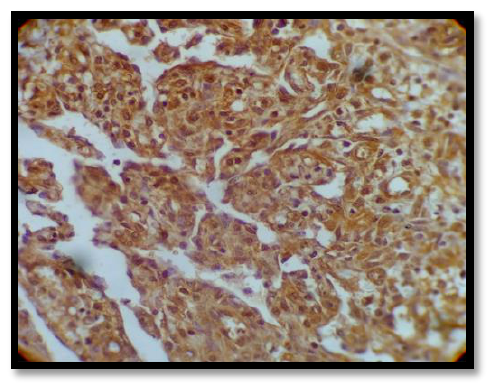
Figure (3): Photomicrograph in hemangioma viewing ESM-1 immunostaining - positive blood vessels(X400)